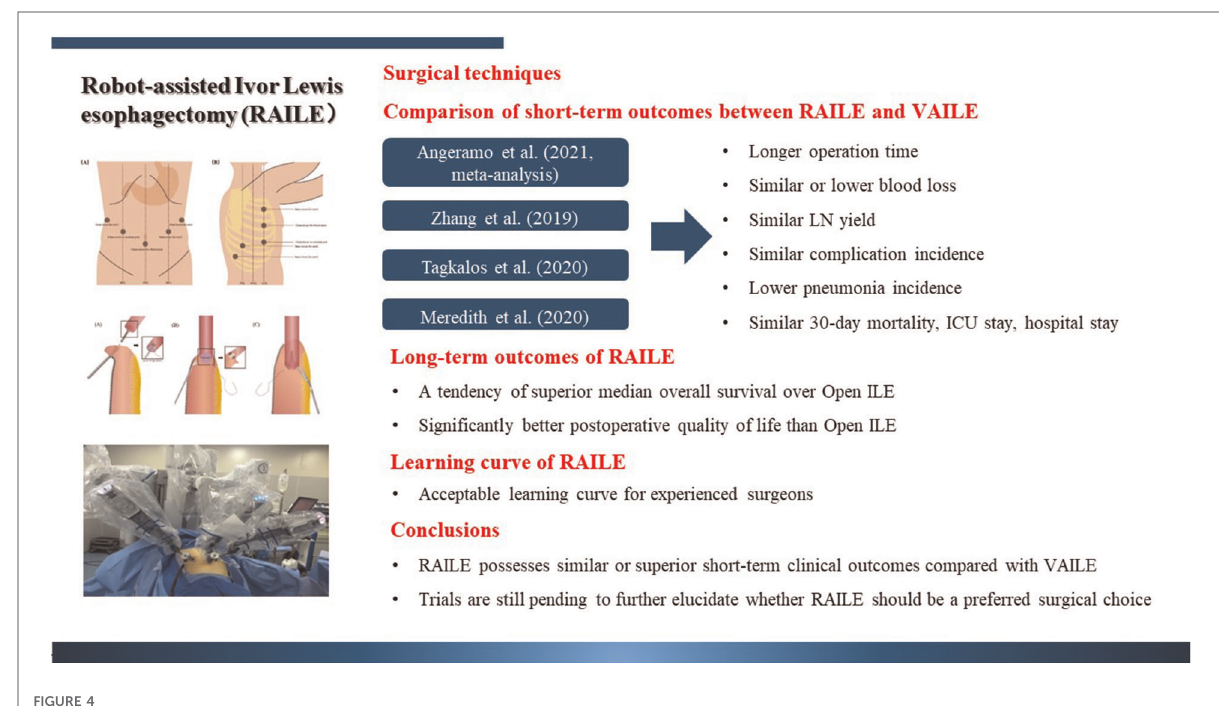
FIGURE 4 Graphical summary of robot-assisted Ivor Lewis esophagectomy and its clinical